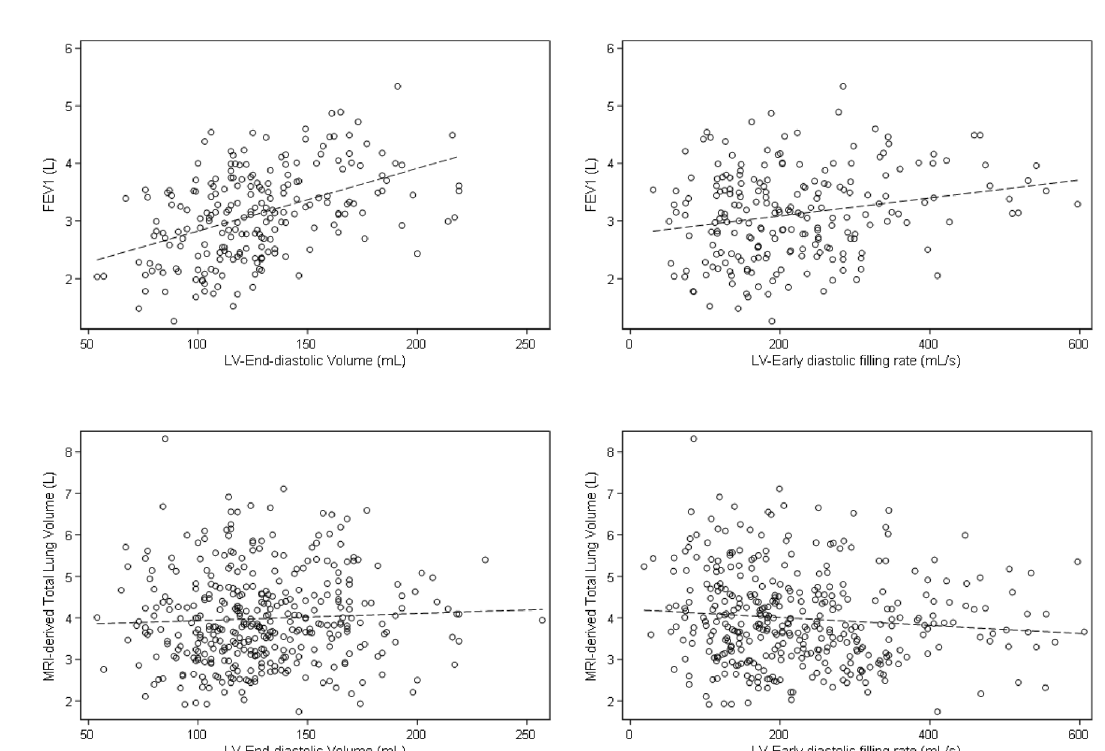
Figure 2. Exemplary plots of the relation of left ventricle parameters with FEV1 and MRI-derived total lung volume (unadjusted). For each association, a regression line (dashed line) is depicted. FEV1 forced expiratory volume in the first second, LV left